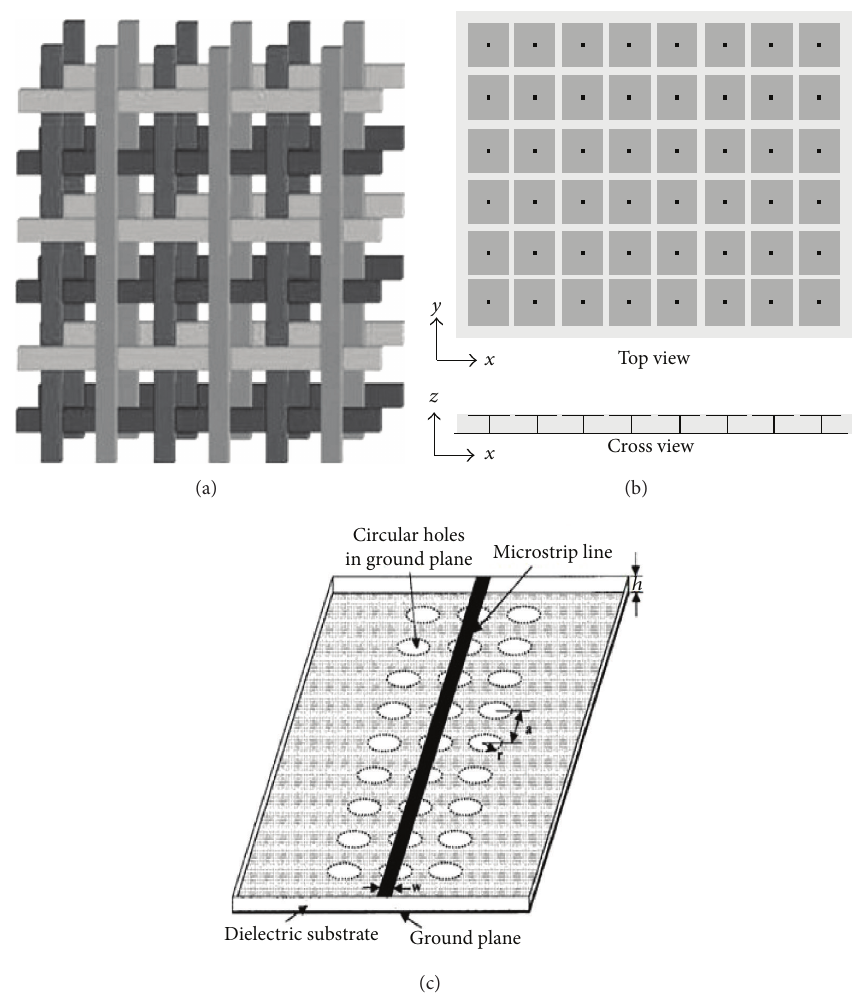
Figure 4: EBG structures: (a) 3-D EBG: a woodpile dielectric structure, (b) 2-D EBG: a mushroom EBG, and (c) 1-D EBG: a microstrip line with periodic holes on the ground